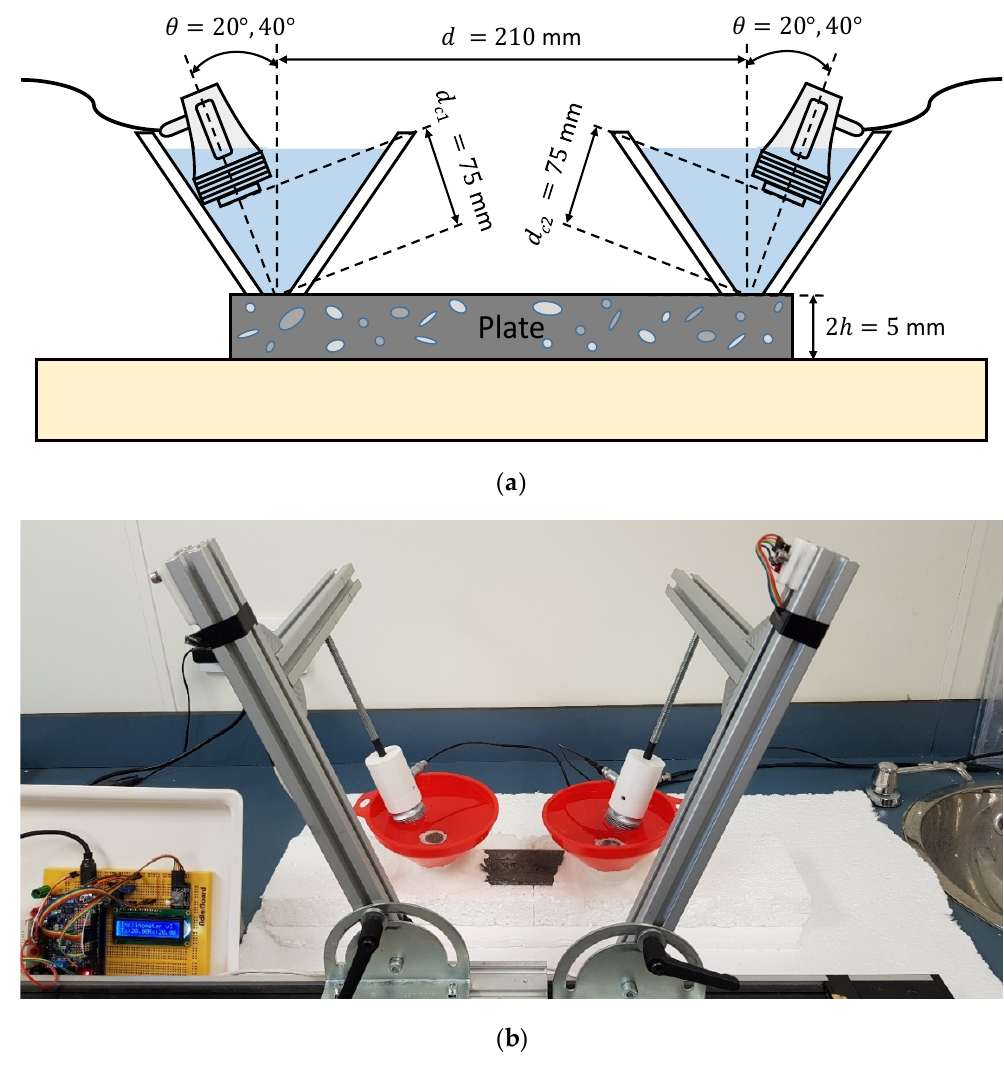
Figure 16. Conical containers setup to measure the mortar plate: ( a ) Schematic; ( b ) Photograph.